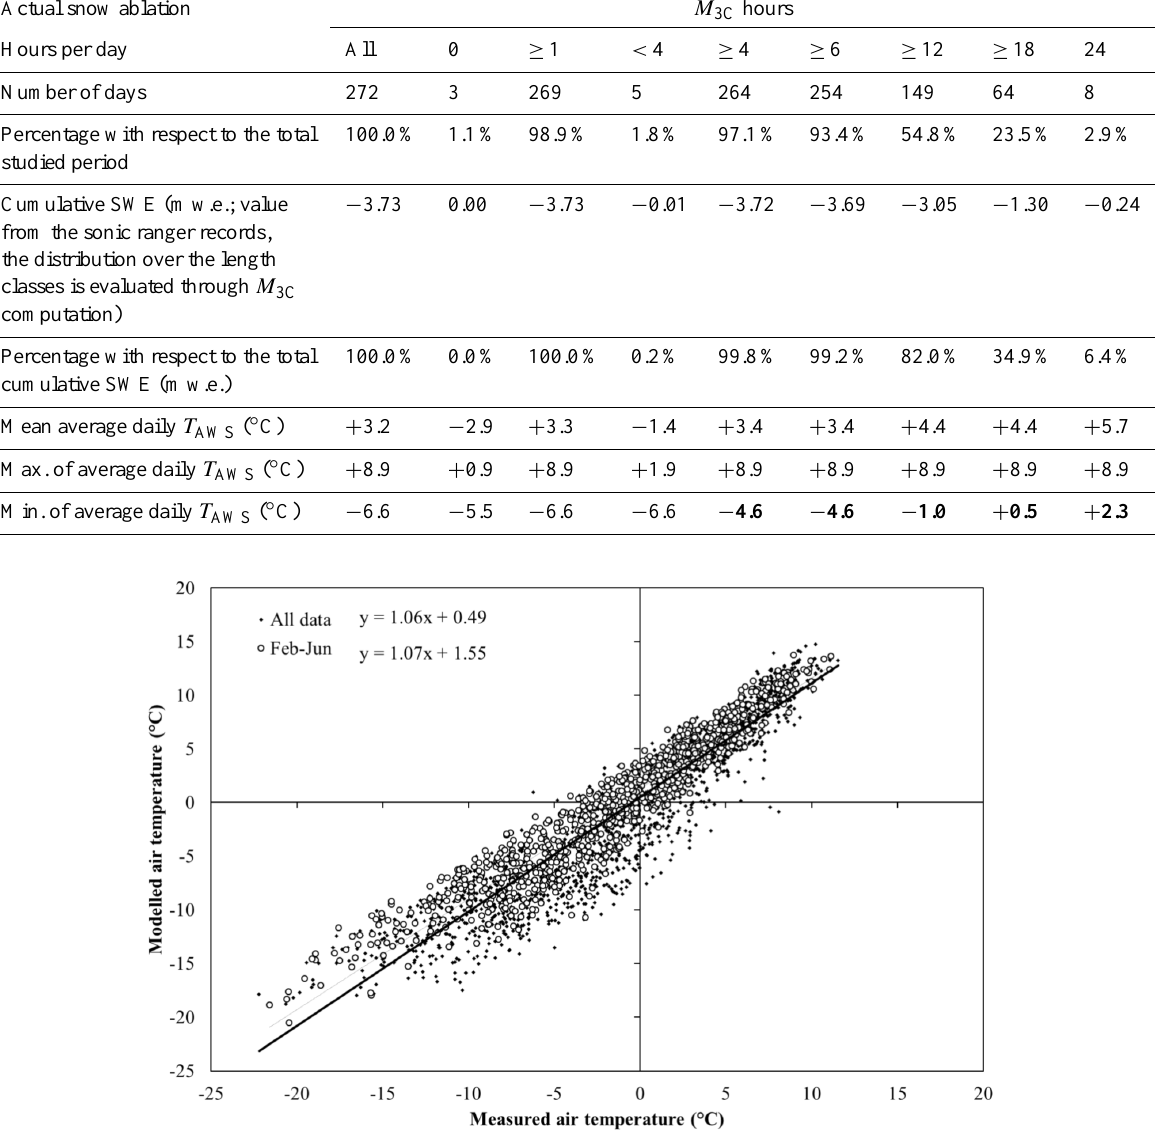
Figure 4. Daily temperatures recorded by the AWS1 Forni ( T AWS ) from 2006 to 2012 ( x axis) vs. the modeled ones ( T B , y axis) derived from Bormio data shifted to the AWS1 Forni elevation through the application of the mean tropospheric lapse